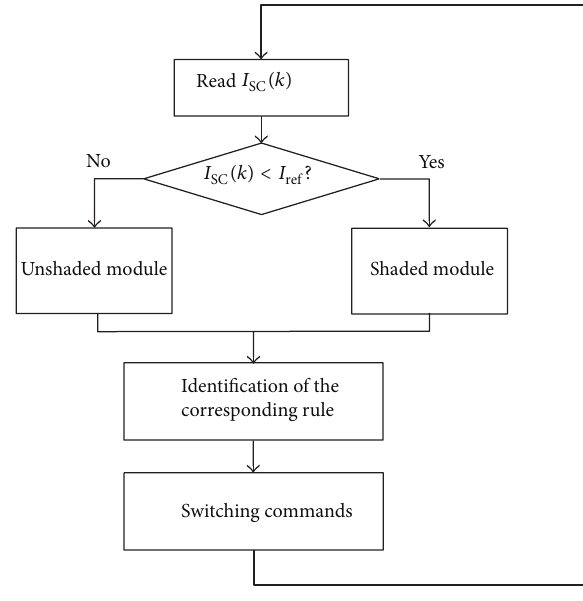
Figure 7: Flowchart of the proposed